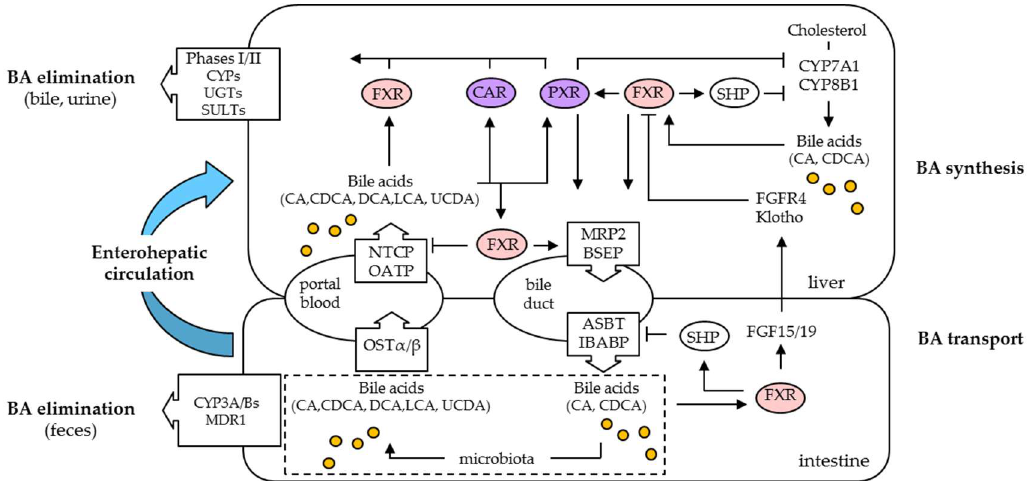
Figure 2. Model of effects of FXRα on bile acid (BA) metabolism. Primary BAs, CA, and CDCA, are generated from cholesterol by liver enzymes, including CYP7A1 and CYP8B1. CA and CDCA are metabolized to DCA and LCA secondary BAs in the intestine. BSEP and MRP2 are localized in the canalicular membrane of hepatocytes and transport BAs into bile. Most BAs are reabsorbed in the intestine and recirculate to the liver through the portal vein in a mechanism called the enterohepatic circulation. BAs that escape reabsorption are excreted in the feces. A portion of secondary BAs enters the enterohepatic circulation from the colon. The transporters ASBT and OSTα/β are involved in BA absorption in the intestine. At the basolateral membrane of hepatocytes, NTCP and OATPs uptake BAs from the portal blood. Activated FXRα, PXR, and CAR induce the expression of phases I and II metabolizing enzymes to stimulate urinary and biliary excretion of BAs.